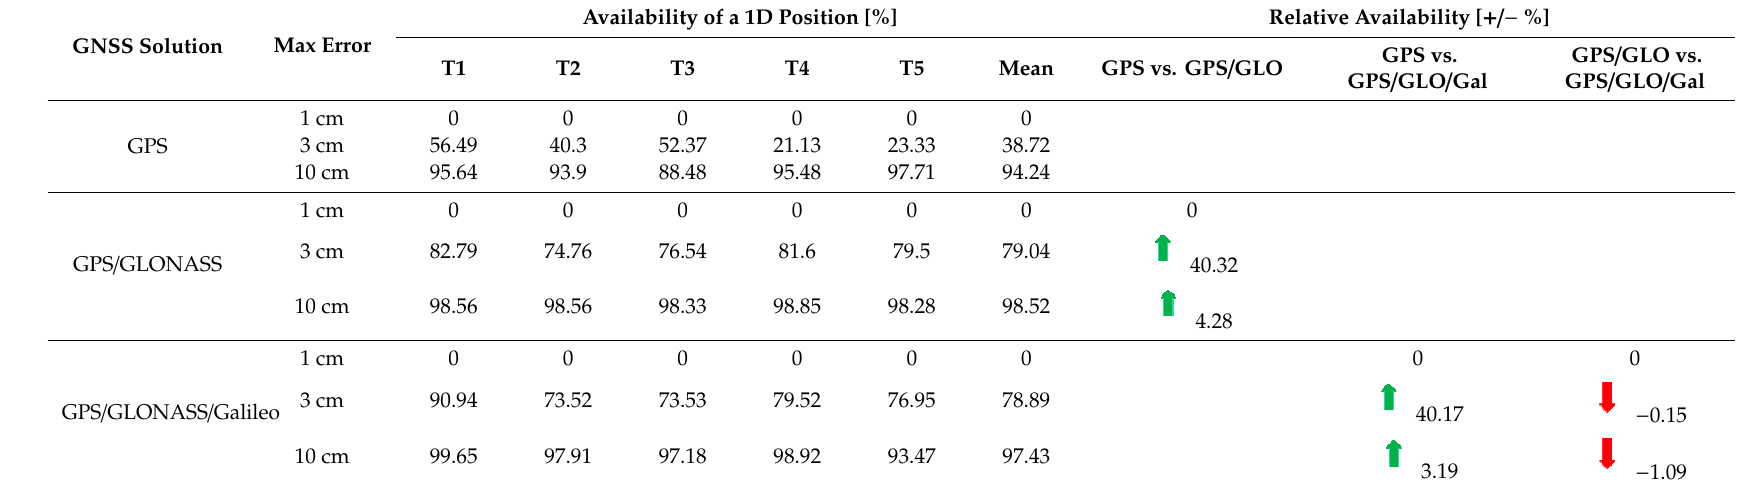
Table 3. The mean and minimum Position Dilution of Precision (PDOP) and the Number of Satellites (NoS) used by the five GNSS geodetic receivers (T1–T5) in measurements during the journeys, with the use of RTK corrections from Global Positioning System (GPS) and GPS/Global Navigation Satellite System (GLONASS) satellites.